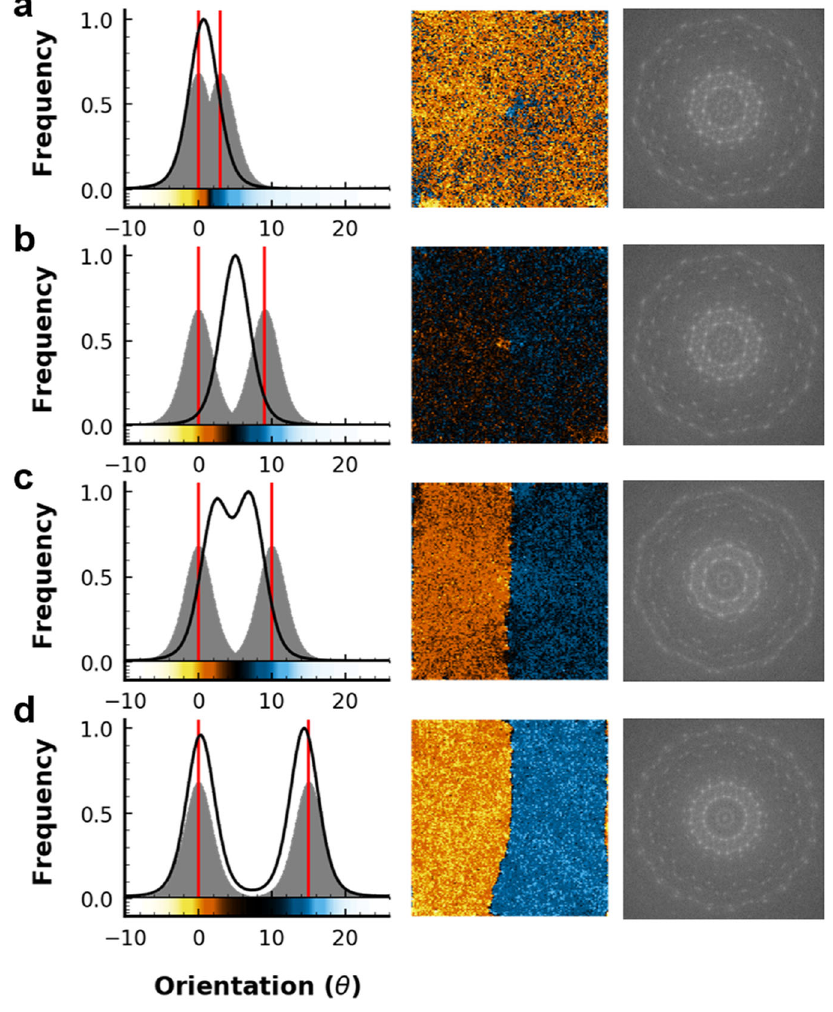
Fig. 3 Simulation orientation analysis. MD simulations showing changes in local grain orientations (LGOs, θ ) towards near-equilibrium con fi gurations (~ 25 million simulation timesteps). Left column: Histograms of simulated (black line) and expected seed LGO distributions (gray peaks). Red lines indicate the expected LGOs of particles in each seed. Histogram bin frequencies (arbitrary units) for simulation lattice orientations were averaged after θ reached a constant value. The thickness of the black line represents the standard deviation of frequency for each bin. Gray peaks are expected probability density functions (PDF) for the reference grain ( θ = 0°) and rotated grain. PDFs are calculated from single-seeded simulations. Peaks for the reference seed are centered at θ = 0° and peaks for the rotated seed are centered at θ = ( a ) 3°, ( b ) 9°, ( c ) 10°, and ( d ) 15°, respectively. Middle column: Spatially binned simulation frames at 25 million timesteps for each set of seeds. Here, coarse-grained images are shown, rather than images with atomic level resolution, because they show grain rotation and GB characteristics more clearly. One pixel or cell represents 20 particles on average. All images show the aperiodic {00001} plane of our d-QC simulations. Colorbars for θ are below each histogram (left) and correspond to the orientation in the histogram axes, where yellow-orange corresponds to particles that align with the reference seed ( θ = 0°). Bright blue corresponds to particles that align with the rotated seed. Dark regions on the colorbar correspond to angles along the shortest arc between 0° and the rotated seed and white regions on the colorbar indicate angles along the longest arc between 0° and the rotated seed. White regions typically correspond to liquid regions, which are not visible in fully crystallized simulations frames (middle column), but are visible during growth, when liquid is still present in simulation. Right column: Calculated diffraction patterns based on the atomic level resolution simulations used in the middle column. Note the diffraction patterns of a and b are indicative of a single d-QC. On the other hand, the diffraction patterns of c and d suggest the presence of two d-QCs with different orange and blue color, respectively, and fl uid-like regions are